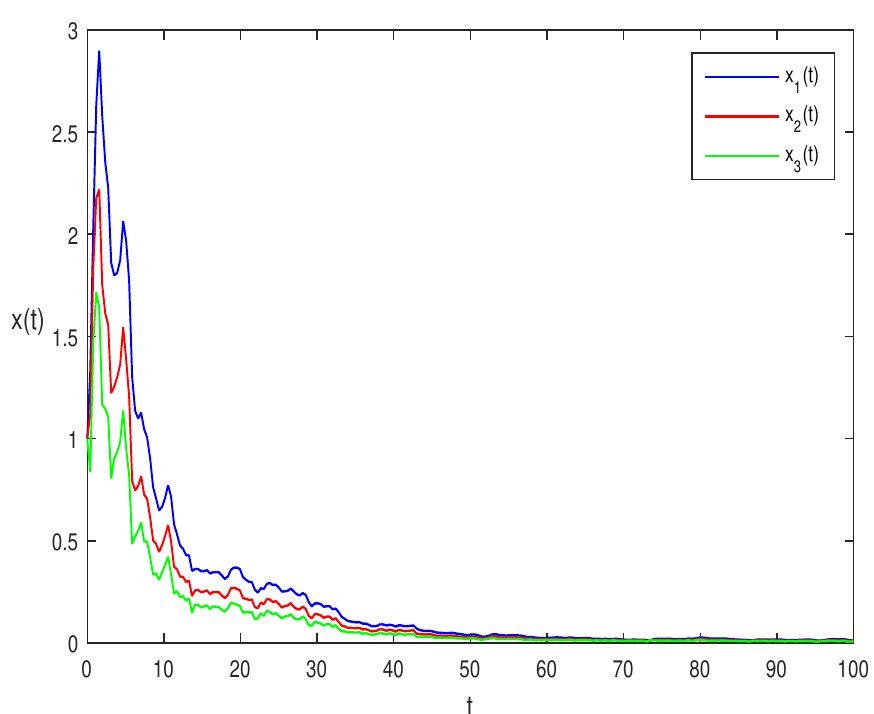
Figure 5. Mean square stable solution for each class of stochastic delay NGM systems from Equation (1).